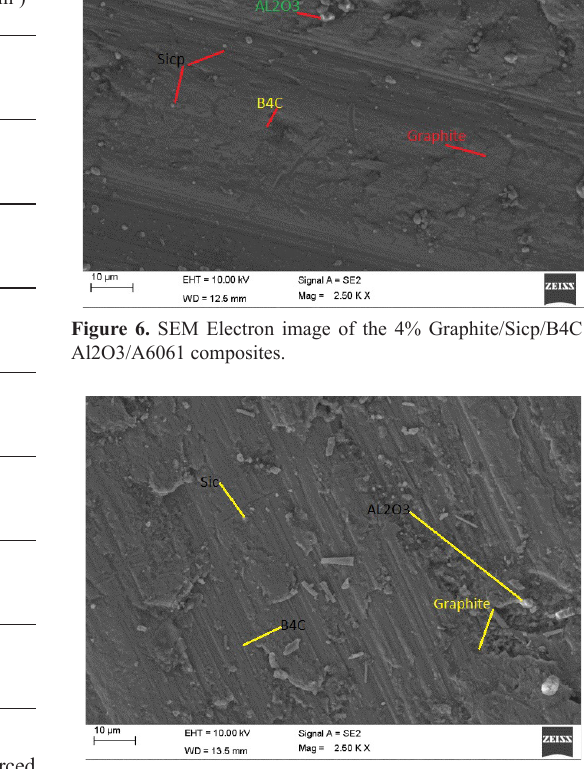
Figure 7. SEM Electron image of the 5% Graphite/Sicp/B4C / Al2O3/A6061 composites.